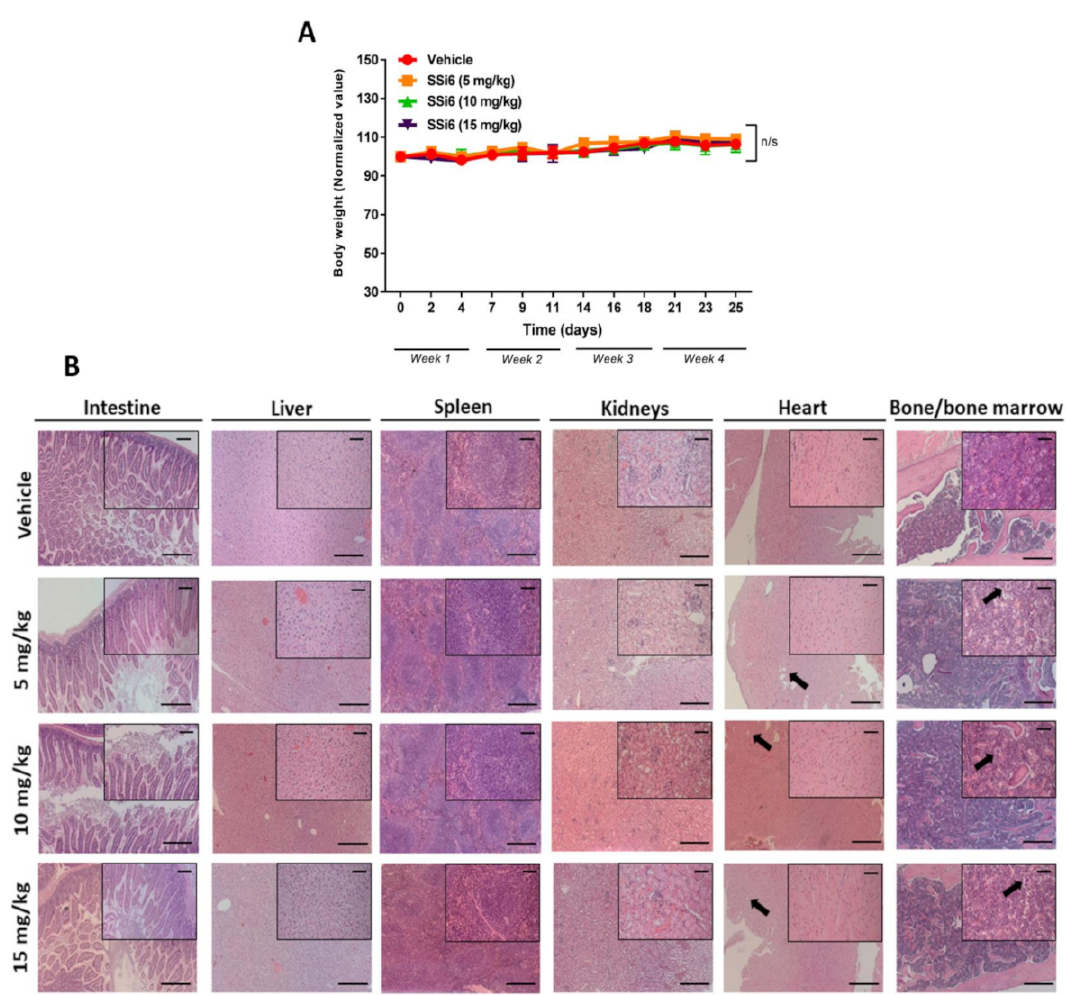
Figure 2. In vivo acute toxicity and tolerance effects of SSi6 doses on FVB mice. FVB female mice were randomly assigned to 4 groups (n = 5/per group) and treated with different doses of SSi6 (5, 10, and 15 mg/kg) and vehicle. During the experiment, body weight was monitored from the start of the experiment until the day of euthanasia. ( A ) Normalized body weight: vehicle group and SSi6 15 mg/kg started with different body weight from the start of treatment. ( B ) Representative photomicrographs of H&E-stained intestine, liver, spleen, kidney, heart, and bone/bone marrow of the female mice were taken. Arrows indicate some foci of subendocardial adipose tissue infiltration into the heart and some hyposegmented megakaryocytes in bone marrow. Images were analyzed and captured with the ZEISS AXIO Imager.M2 microscope, scale bar = 200 µ m (low magnification) and 50 µ m (high